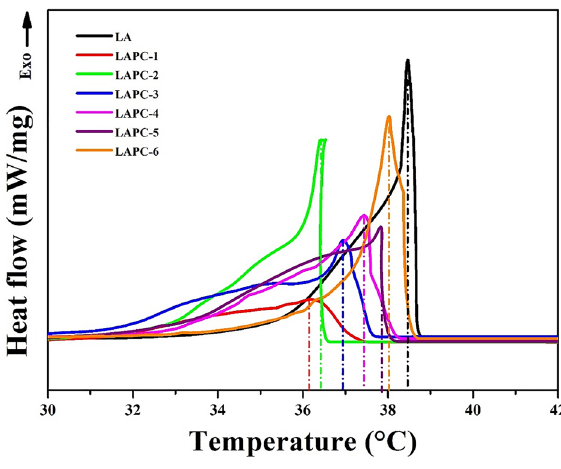
Figure 11. Solidifying curves of LA and microencapsulated LA/SiO 2 .